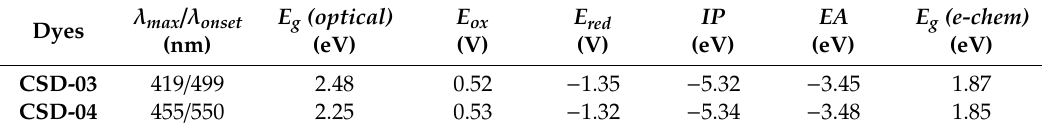
Table 1. Summary of optical and electrochemical properties of the as-synthesized dyes. Dyes